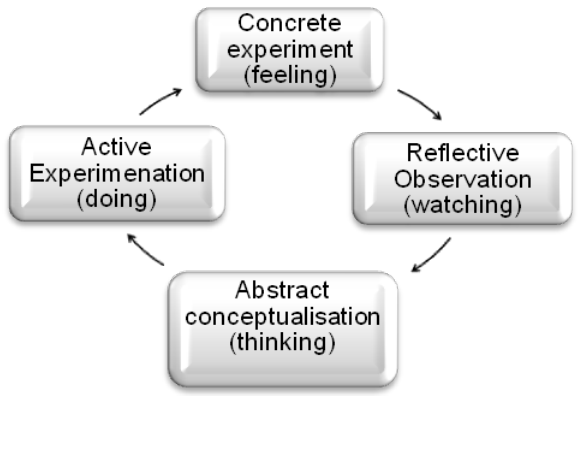
Figure 1: Kolb's learning cycle